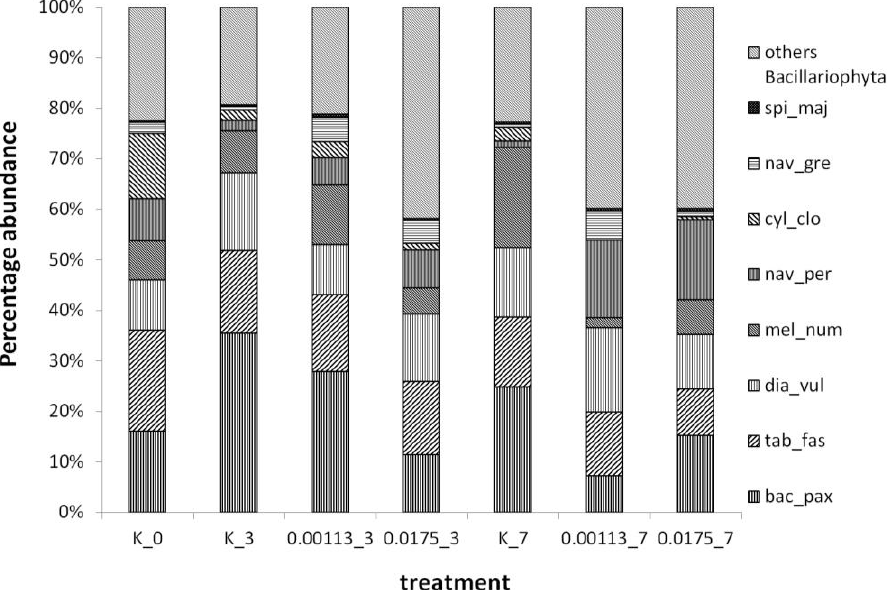
Figure 5. Percentage abundance of the 8 most important species distinguished in the tested commu-